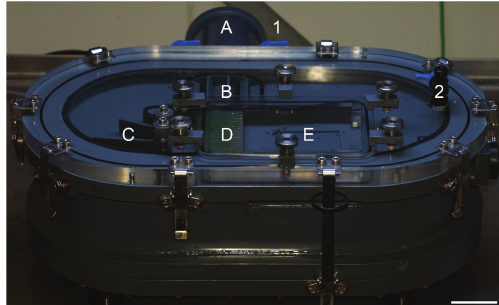
Figure 1: Overview of the respirometric flow cell used in this study. A: motor. B: paddle wheel. C: flow adjusters. D: flow laminator. E: coral plate holder. 1: water inlet. 2: water outlet. Scale bar: